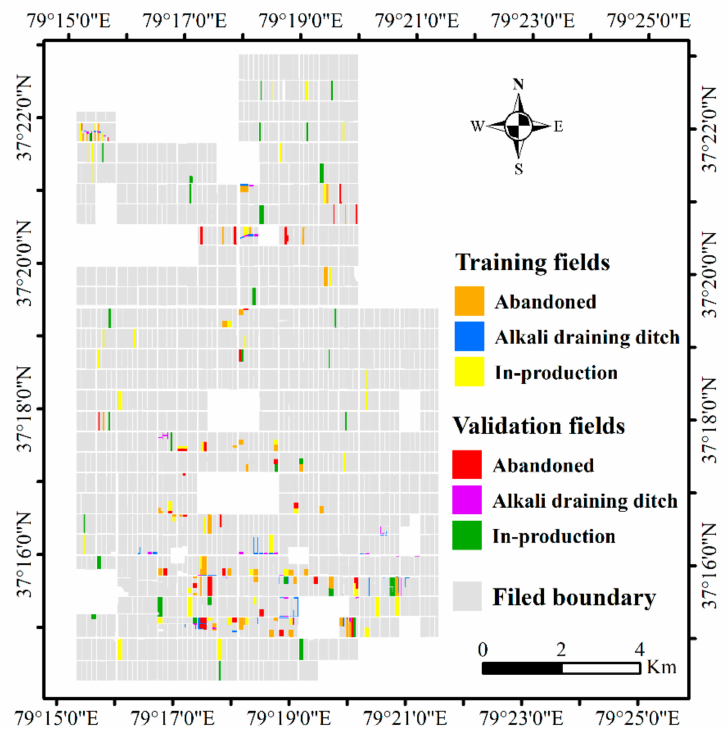
Figure 4. Location of ground surveyed fields in September